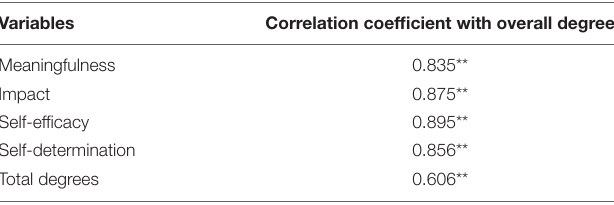
TABLE 8 | Correlation coefficients between the dimensions of the Psychological Empowerment Scale and the total degree of the scale.